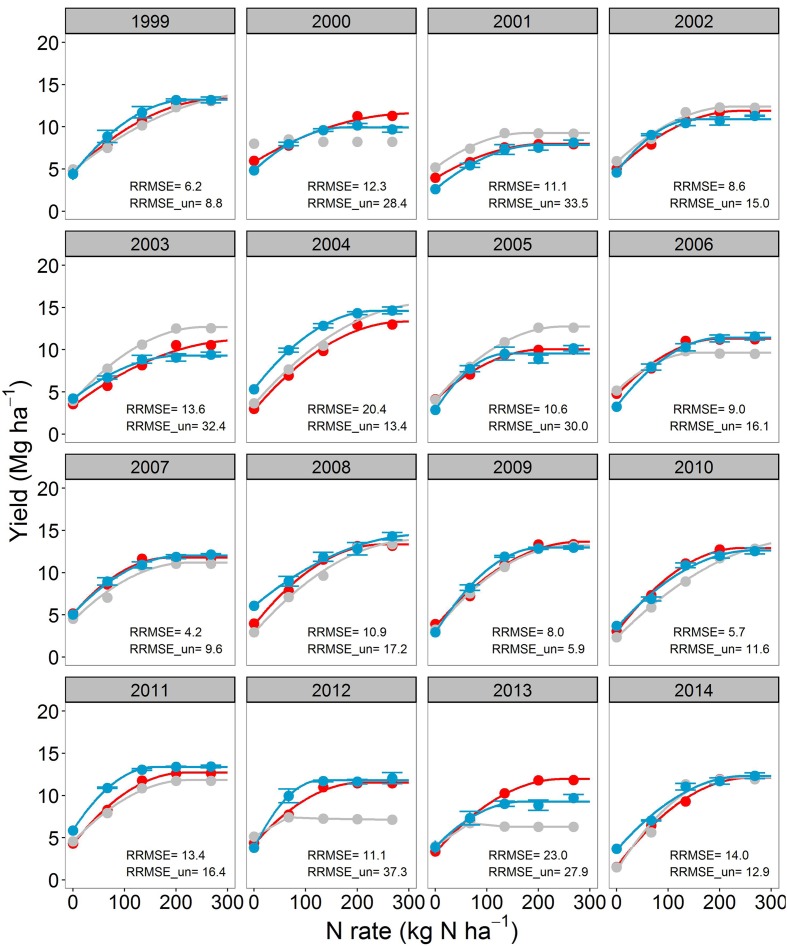
Corn yield response to N fertilizer for the continuous corn (CC) cropping system. The blue points with standard errors (n = 4) indicate the observations. The gray and red points are Agricultural Production Systems sIMulator (APSIM) simulations before and after calibration, respectively. Continuous lines are regression fits from Eqs. 1–3. When lines are not shown it means that Eqs. 1–3 did not converge. Relative root mean square error for both calibrated (RRMSE) and uncalibrated model (RRMSE_un) are shown for each year.